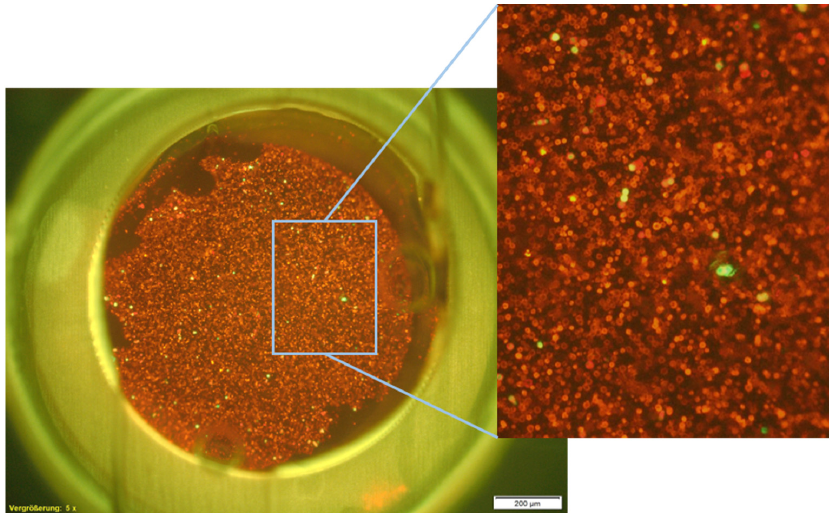
Figure 6. Leukocytes stained with anti-CD45-PE (orange) and spiked HCT116 cells stained with anti-EpCAM-FITC (green) captured on the TEM-grid. Detected by fluorescence microscopy at 50-fold magnification and 200 ms illumination time. The images were recorded separately in the respective channel and overlaid afterwards.